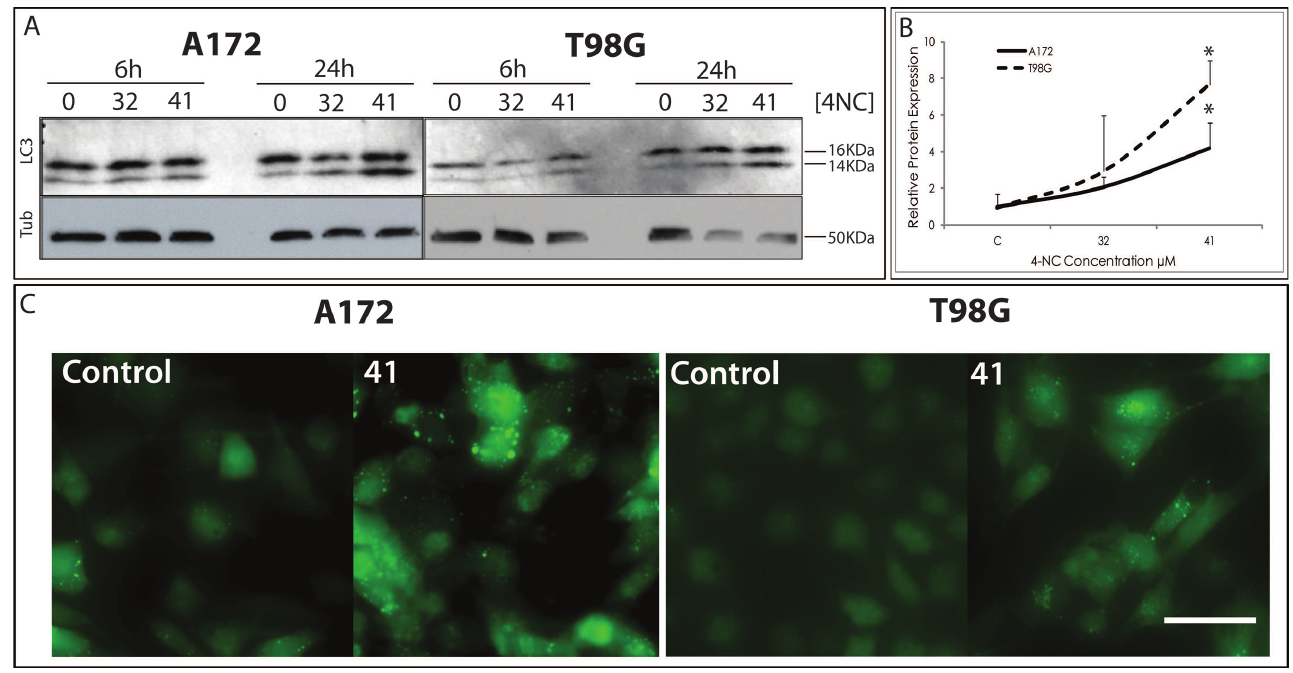
FIGURE 2 - 4-NC induction of autophagy by the increase of